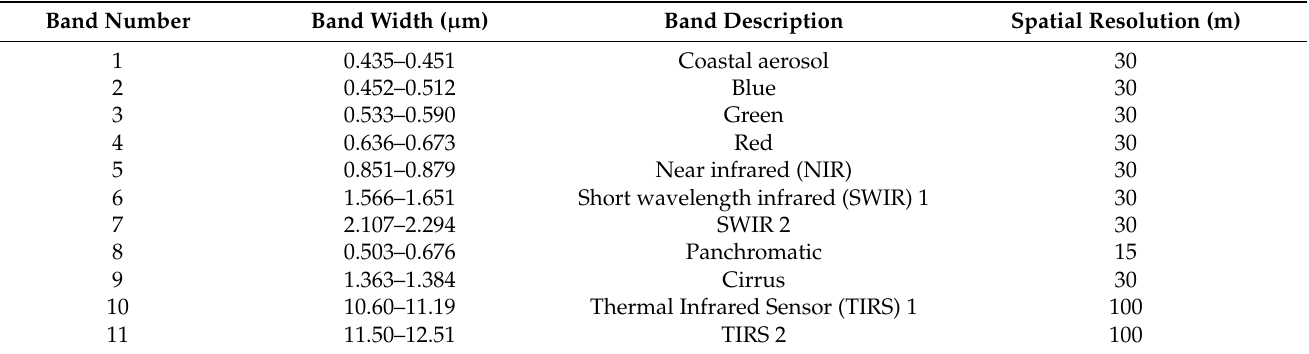
Table 1. Bandwidth and spatial resolution of the 11 bands of the Landsat-8 OLI/TIRS